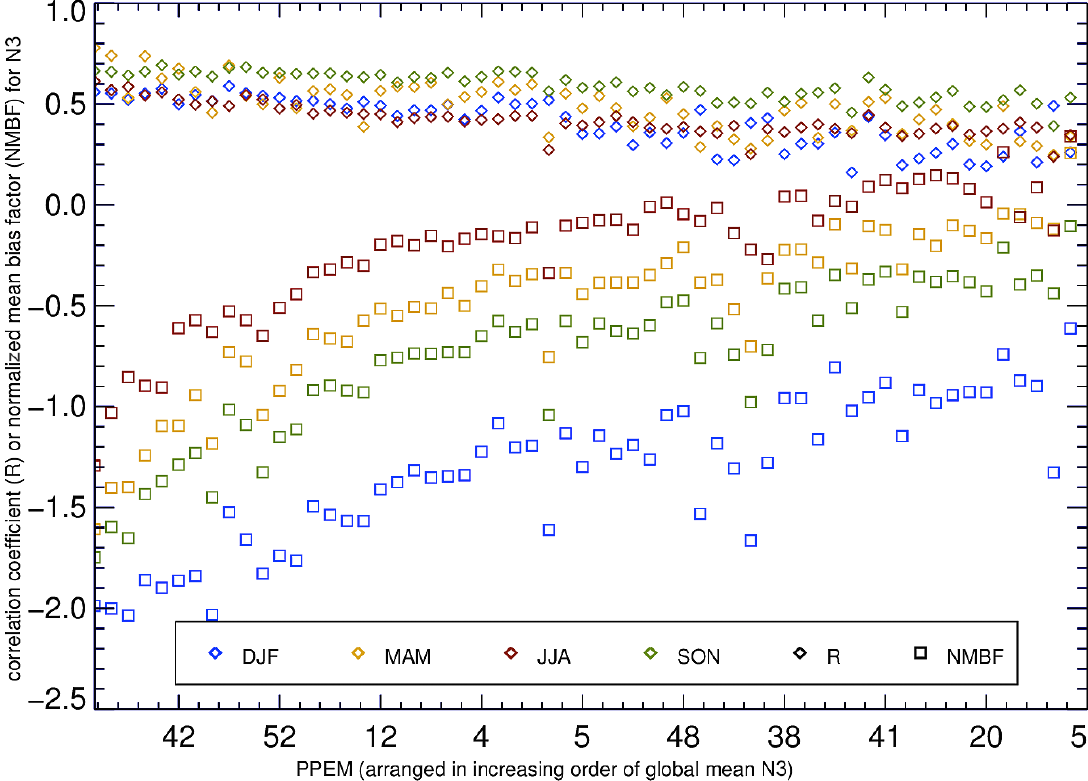
Figure A2. Correlation coefficient (diamonds in blue for winter, yellow for spring, red for summer, and green for autumn) and and normalised mean bias factor (squares in blue for winter, yellow for spring, red for summer, and green for autumn) shown against each perturbed parameter ensemble member (PPEM). The simulations are arranged in order of increasing global mean surface-level N3 (as in Fig. 5) with every sixth simulation labelled on the x axis. The order of simulations on the x axis: 55, 53, 23, 58, 16, 42, 44, 33, 40, 46, 34, 52, 35, 7, 13, 24, 2, 12, 17, 60, 10, 37, 14, 4, 1, 26, 3, 28, 39, 5, 25, 31, 19, 18, 30, 46, 29, 47, 11, 56, 50, 38, 22, 43, 9, 49, 45, 41, 32, 36, 6, 21, 8, 20, 15, 57, 59, 27, 51,